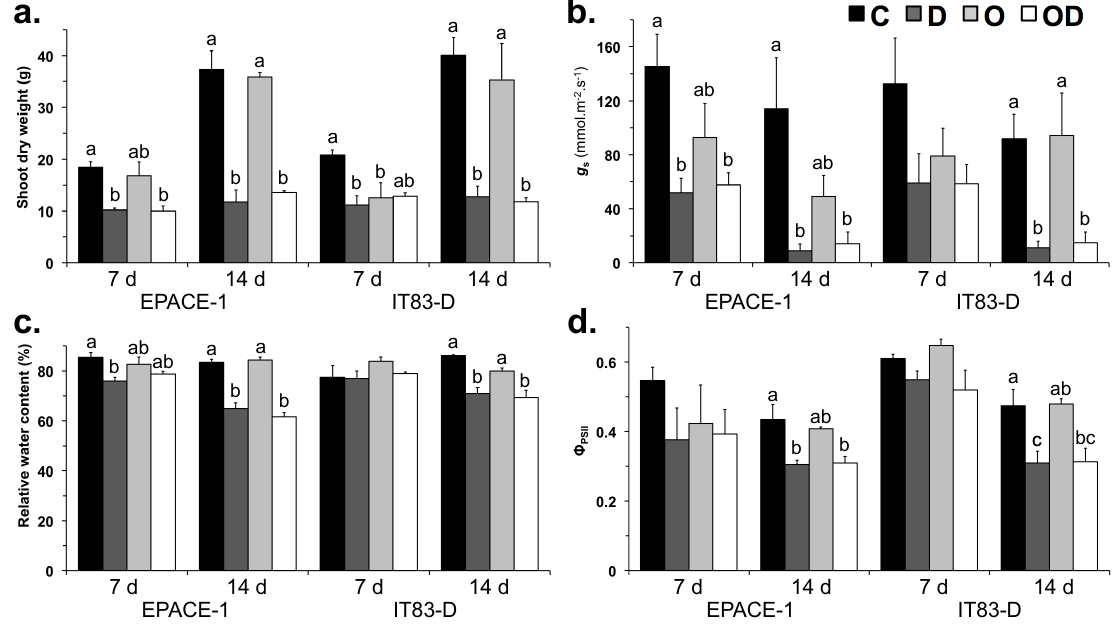
Figure 1. ( a ) Shoot dry weight; ( b ) stomatal conductance ( g s ); ( c ) relative water content and ( d ) quantum yield of PSII ( Φ PSII ) of Vigna unguiculata plants subjected to the following treatments: Control (C, black bars), Drought (D, dark grey bars), Ozone (O, light grey bars), Ozone + Drought (OD, white bars). Measurements were performed 7 and 14 days after the onset of the stress treatments. Means ± SEM are shown ( n = 3–4). When significant differences were found, letters indicate homogenous subsets at each time point for a given cultivar (one-way ANOVA and Tukey post-hoc tests, α = 0.05).